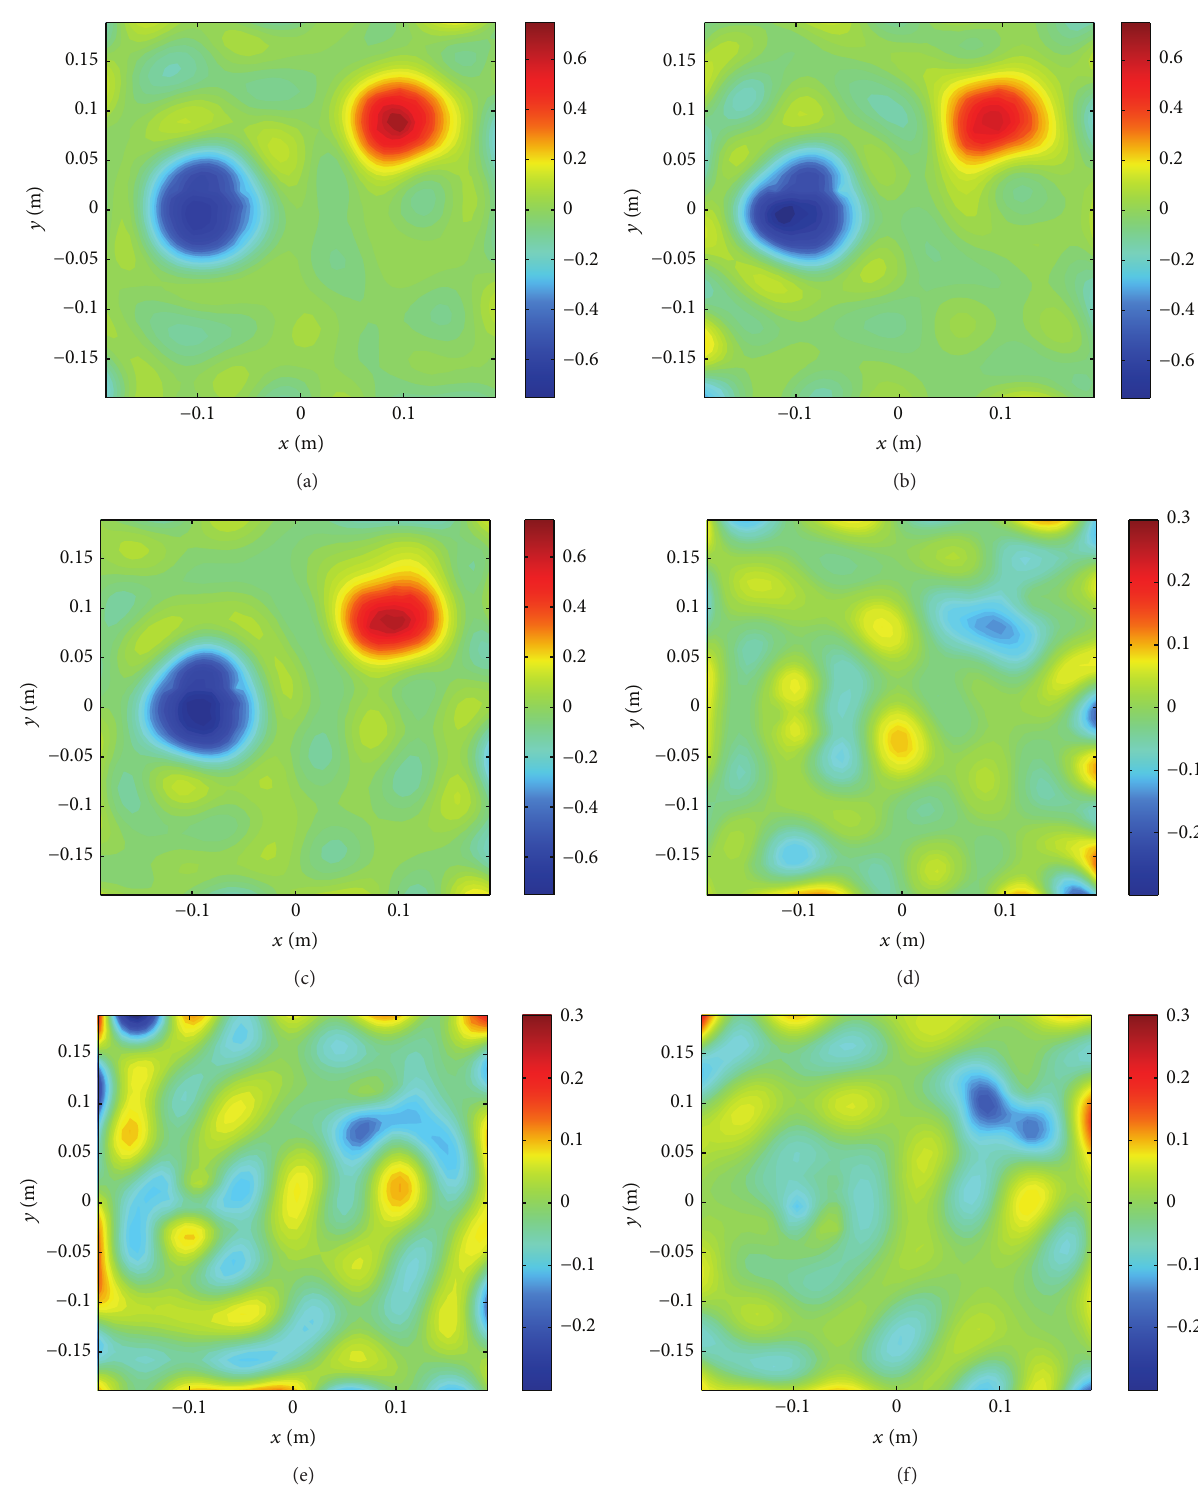
Figure 9: Example 1: QLSM reconstructions by using measurement configuration A. ((a), (d)) Real and imaginary parts of retrieved profiles in a circular scanner; ((b), (e)) real and imaginary parts of retrieved profiles in a square scanner; ((c), (f)) real and imaginary parts of retrieved profiles in a triangular